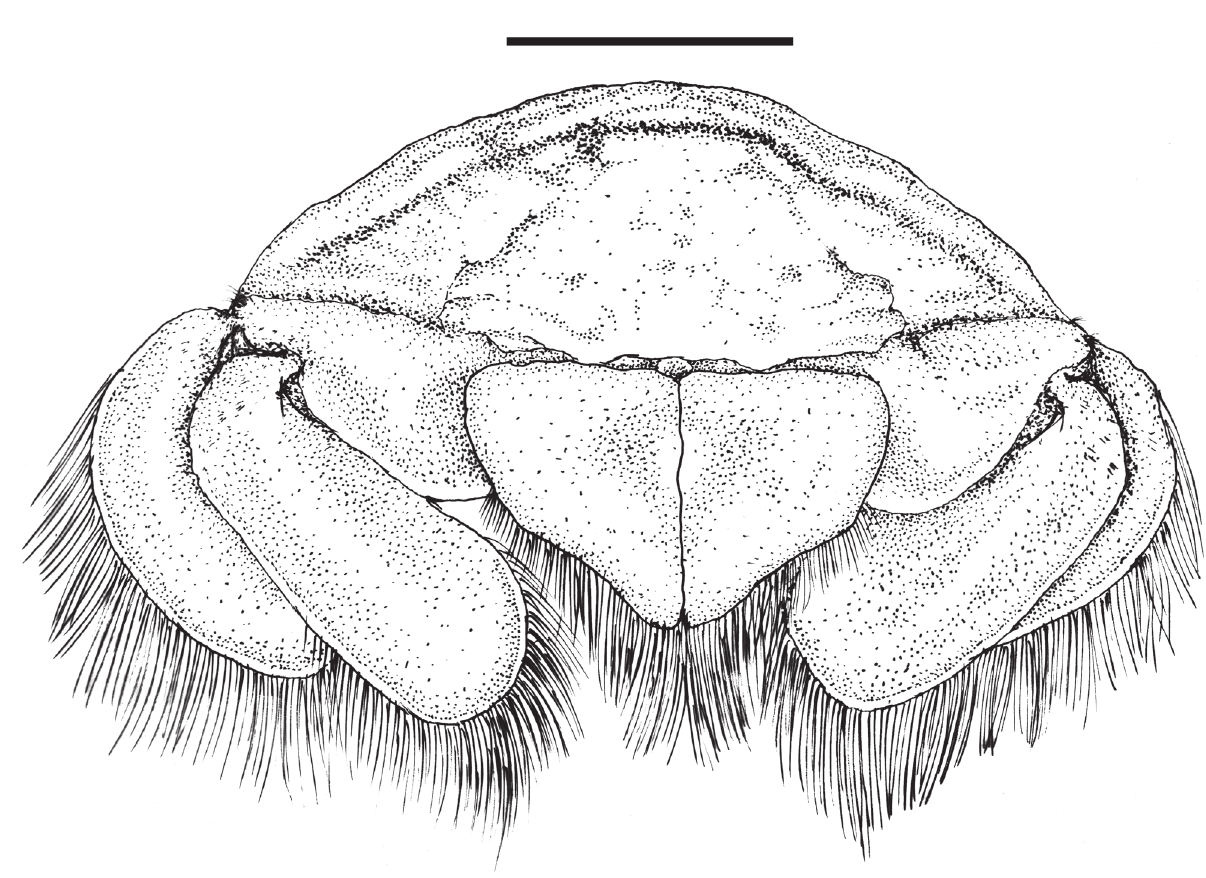
Figure 9. Aegla charon n. sp., male, holotype (MZUSP 35193), telson and uropods. Scale bar = 5.0 mm.